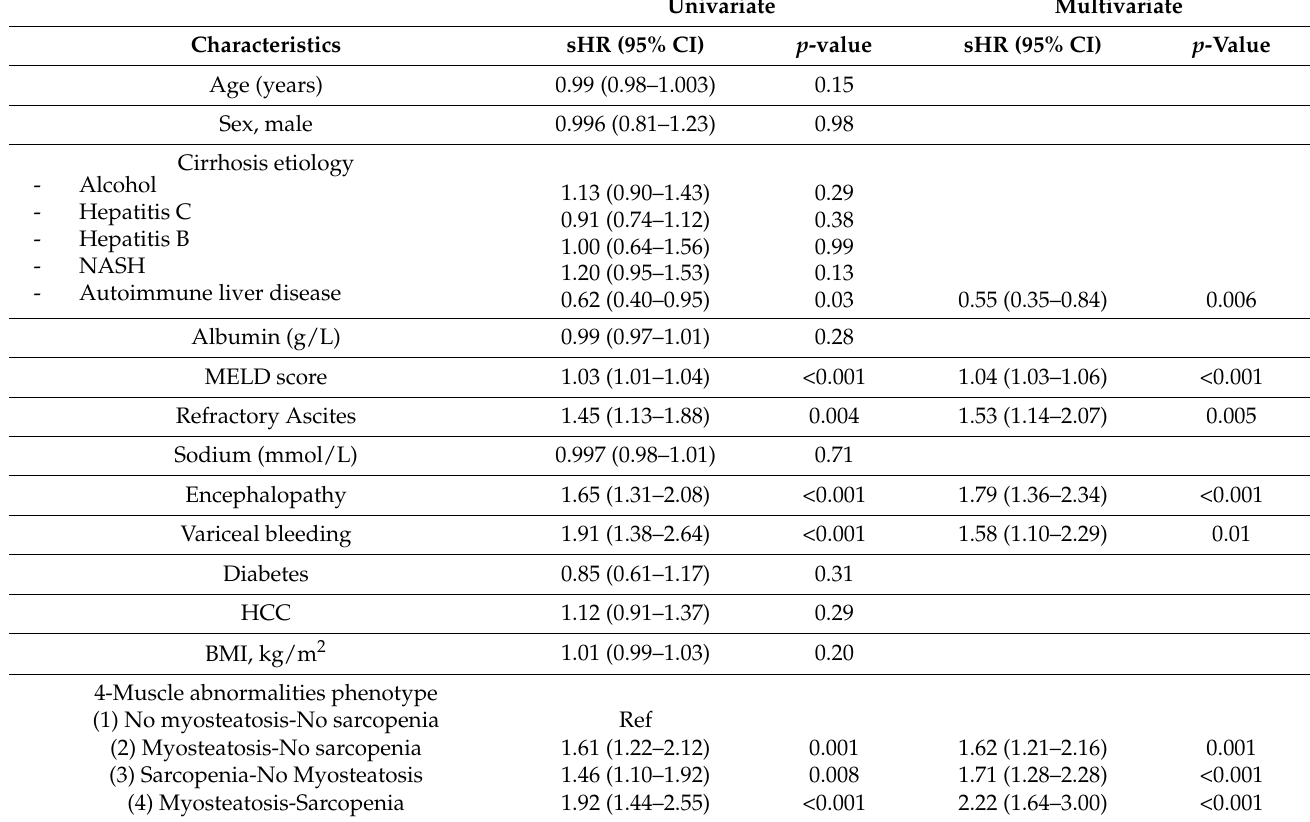
Table 3. Association between 4-muscle abnormality phenotypes and mortality. Univariate